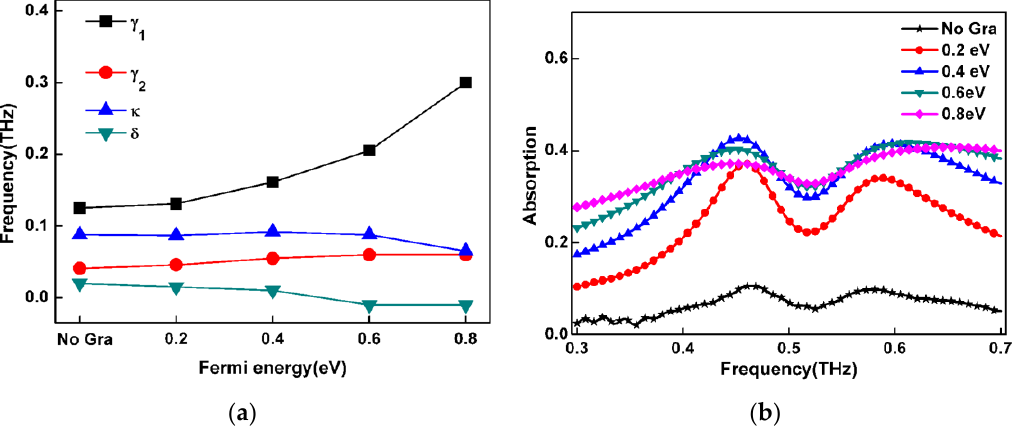
Figure 4. ( a ) The fitting parameters for different Fermi energies. ( b ) The simulated spectra of the absorption in the PIT structure with different Fermi energies.